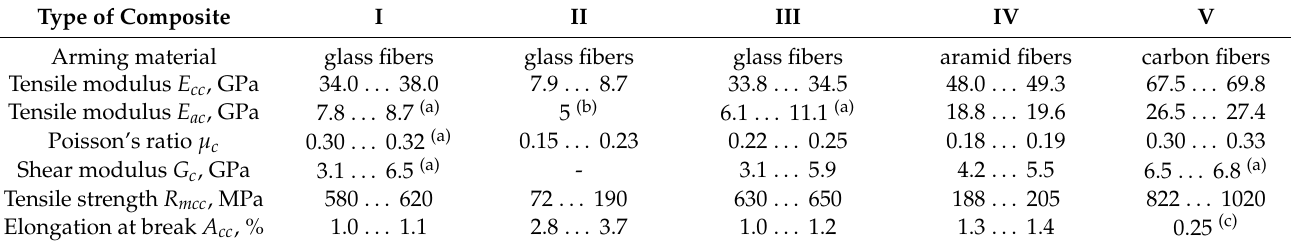
Table 1. Main mechanical properties of the composite materials intended for pipeline